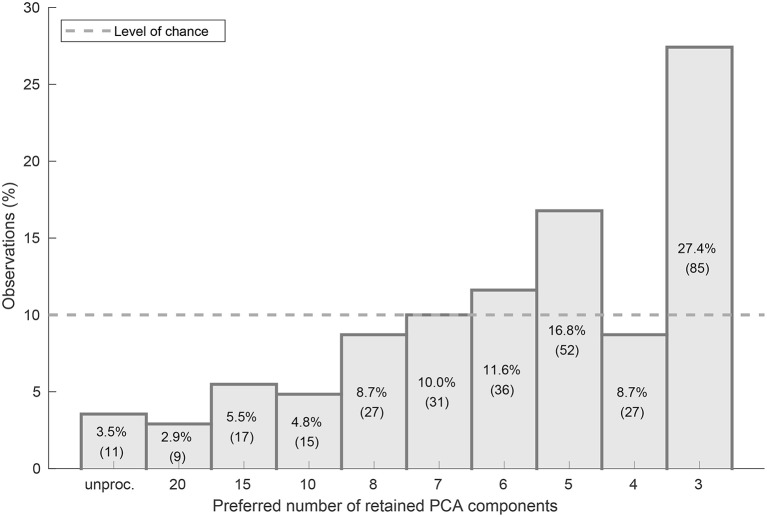
Histogram plot of the numbers of observations per complexity reduction level in percent of overall 310 observations. The level of chance is indicated by the dashed horizontal line.